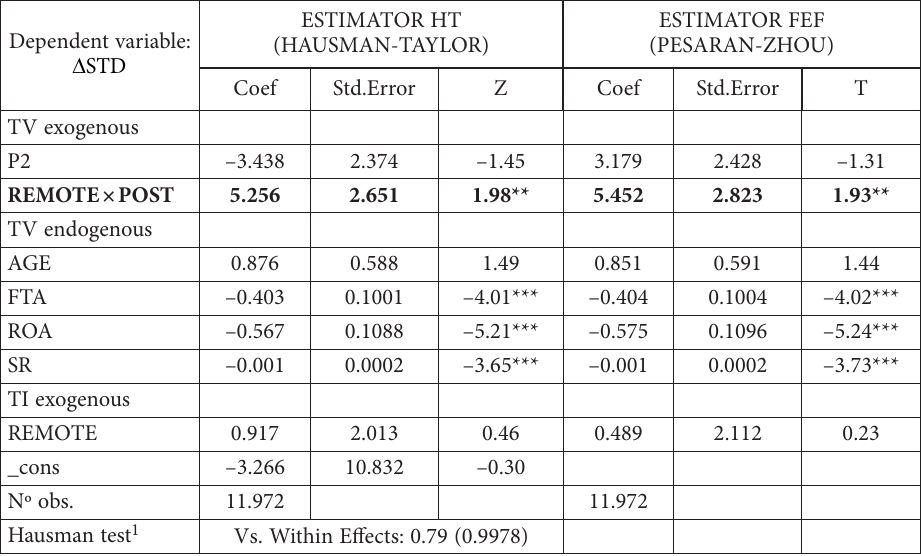
Table 5. Testing the causal effect of rurality over the flow of bank